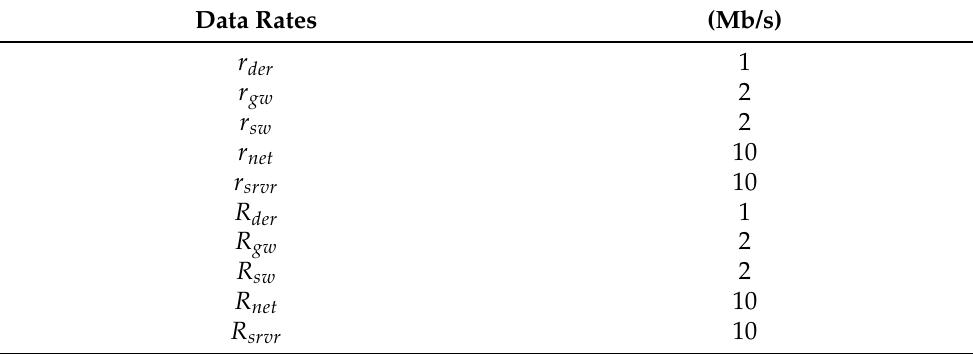
Table 1. Parameters for Data Flow Model.